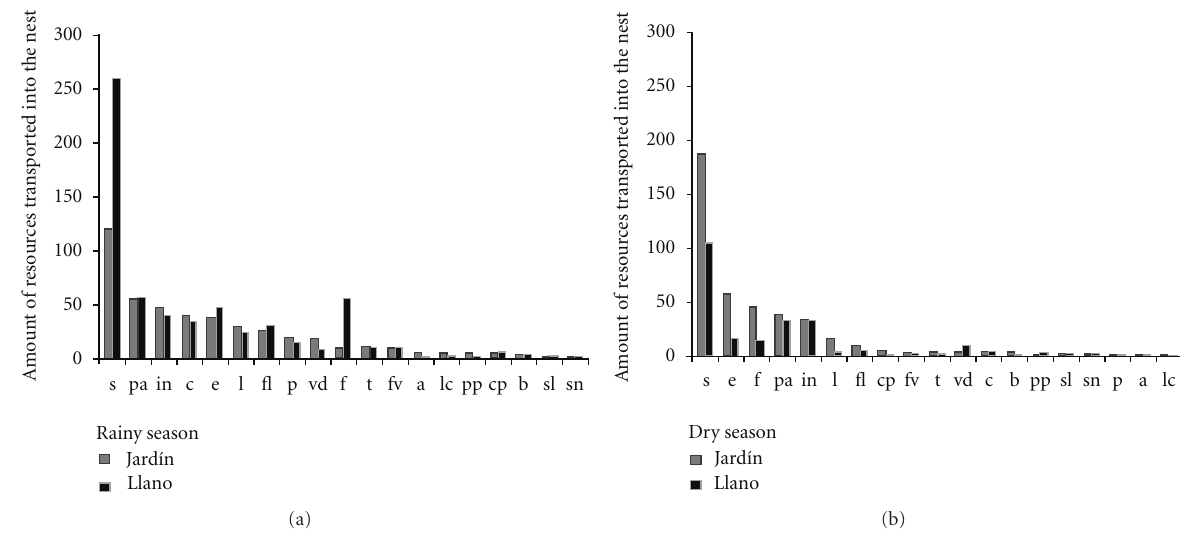
Figure 2: Resources removed from the ant mandibles during the rainy and dry season in two contrasting sites at the “Helia Bravo” Botanical Garden at Zapotitl´an de las Salinas, Puebla, Mexico. a: algae; b: buds; c: capitate; cp: caterpillars; e: excretes; f: fruits; fl: flowers; fv: fleshyvegetal tissue; in: insects; l: leaves; lc: lichen; p: peels; pa: pieces of arthropods; pp: pupae; s: seeds; sl: soil; sn: snails; t: twigs; vd: vegetal